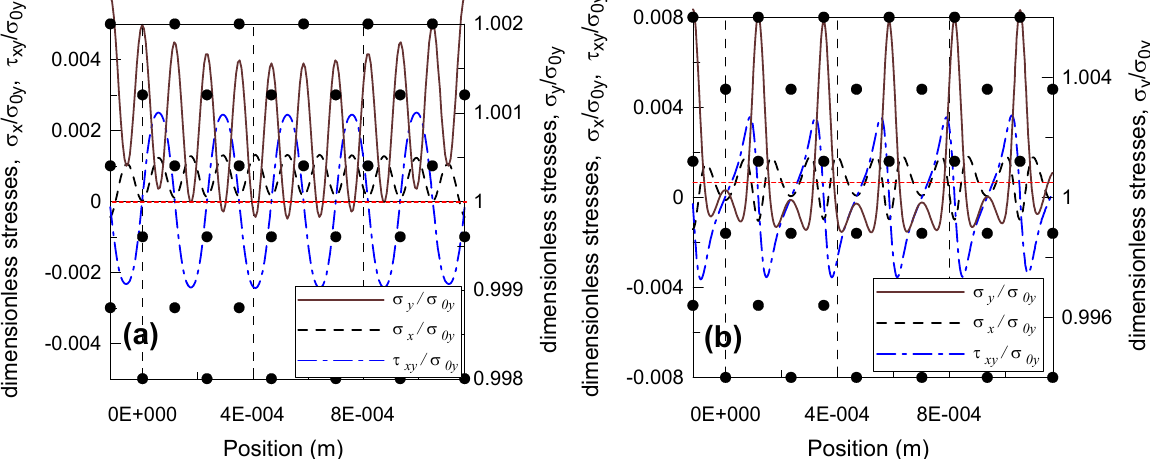
Figure 4: Stresses along a horizontal straight path (dashed line) located at (a) half distance and (b) one-third distance between two lines of inclusions, in an infinite plane under plane stress remote uniform tension stress the